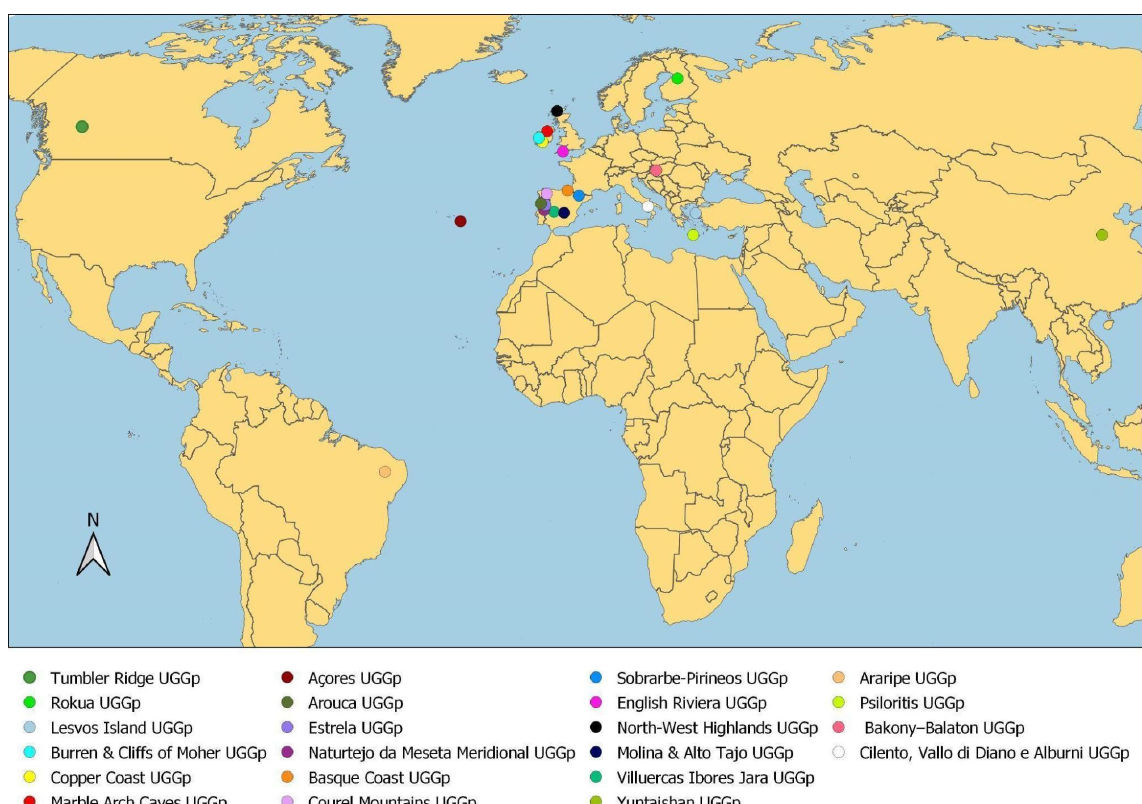
Figure 2. Geographic distribution of UNESCO Global Geoparks with educational materials on their websites or in published scientific